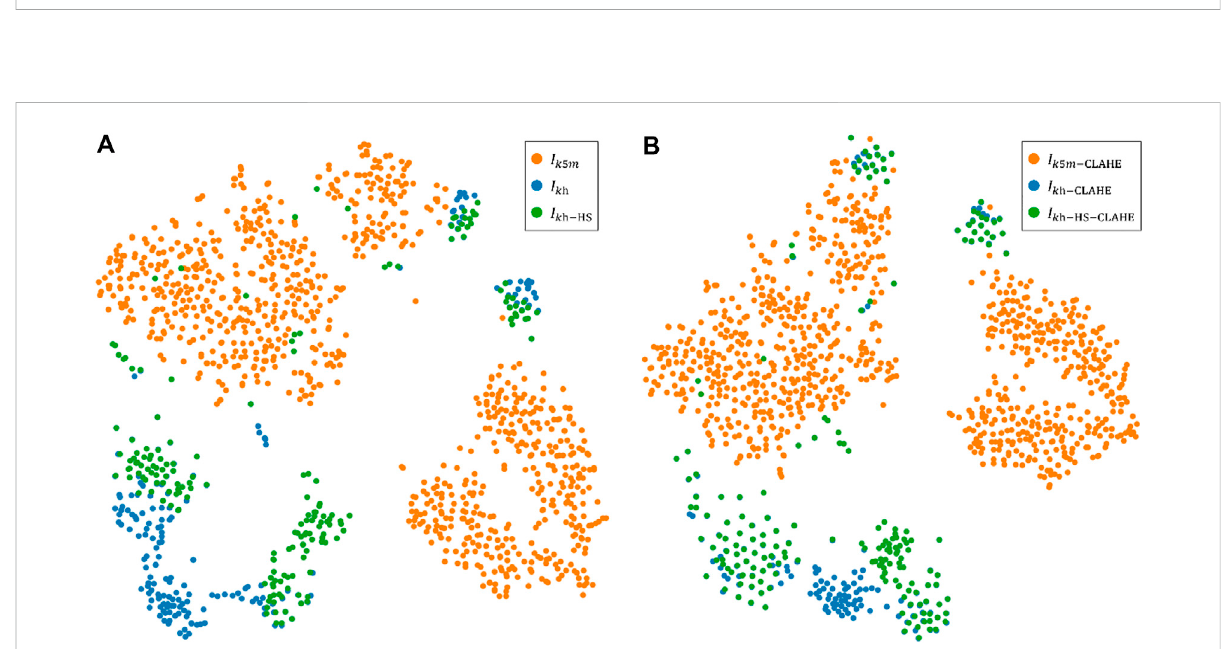
FIGURE 9 Execution of t-SNE algorithm for images from two different devices. Colors represent data from different devices. (A) A visualization of the t-SNE 2D non-linear embedding projection for the images without CLAHE. (B) A visualization of the t-SNE 2D non-linear embedding projection for the images with CLAHE for contrast